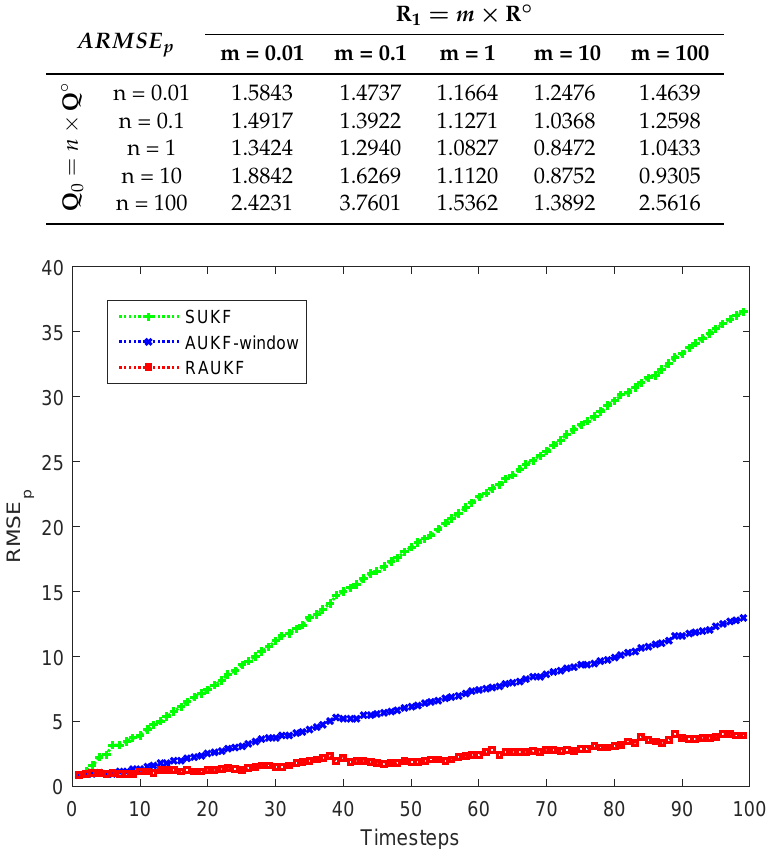
Figure 2. Comparison of RMSE p ( k ) results of different algorithms when Q 0 = 100 × Q ◦ and R 1 = 0.01 × R ◦